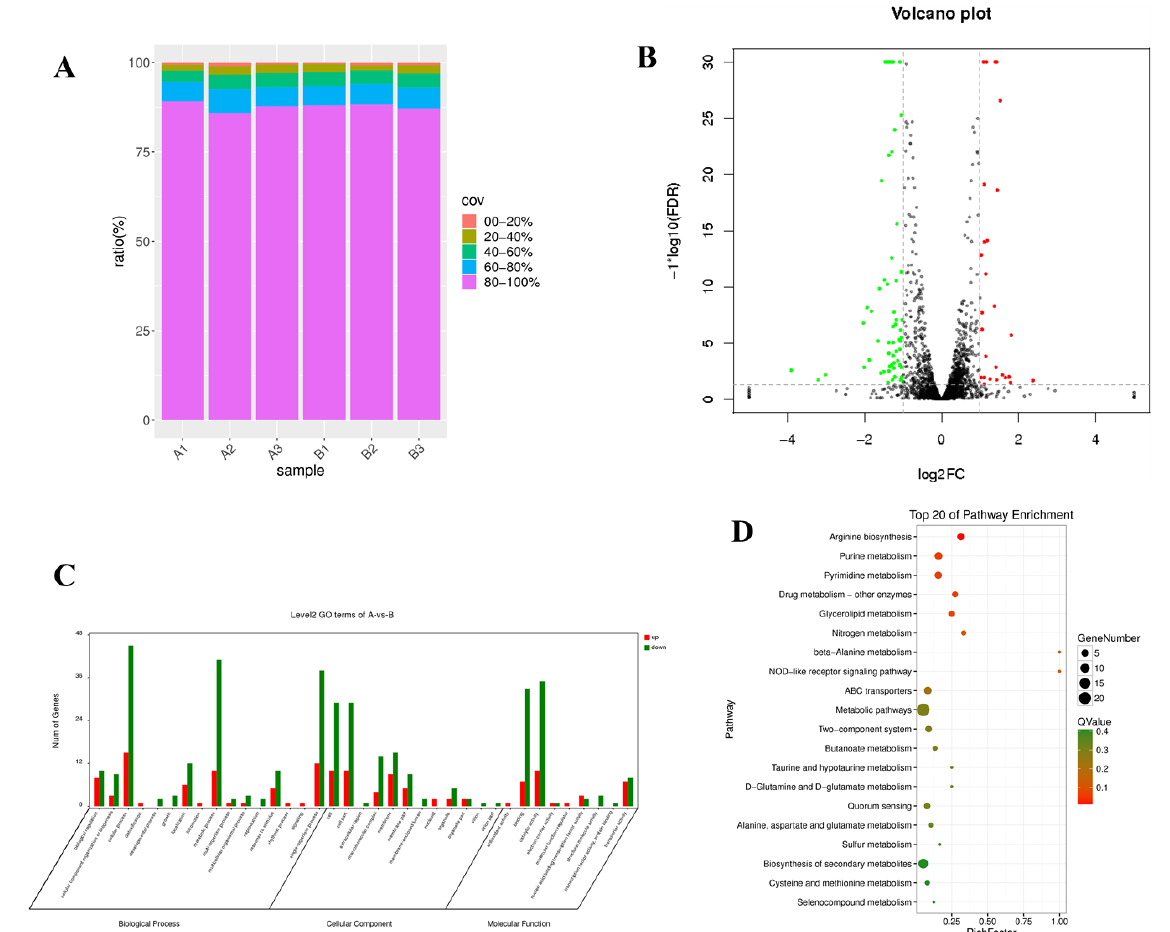
Figure 4. Transcriptome sequencing results and analysis. ( A ) L. lactis and A32 gene coverage; ( B ) map of significant DEGs; ( C ) GO classification of DEGs; ( D ) statistical characteristics of DEG enrichment in KEGG pathways. Genes with no significant difference in expression are shown in black, upregulated genes are shown in red and downregulated genes are shown in green.